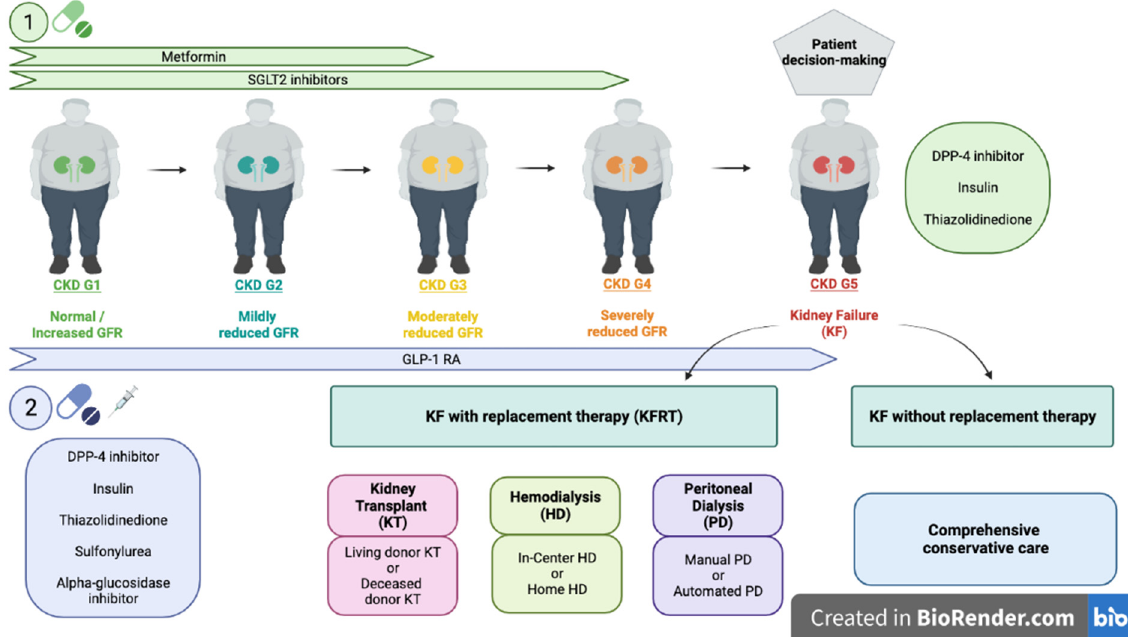
Figure 1. DKD progression and management recommendations using nomenclature recommended by Executive Summary and Glossary from a Kidney Disease: Improving Global Outcomes (KDIGO) Consensus Conference ① and KDIGO Diabetes Management in CKD Guideline ② .